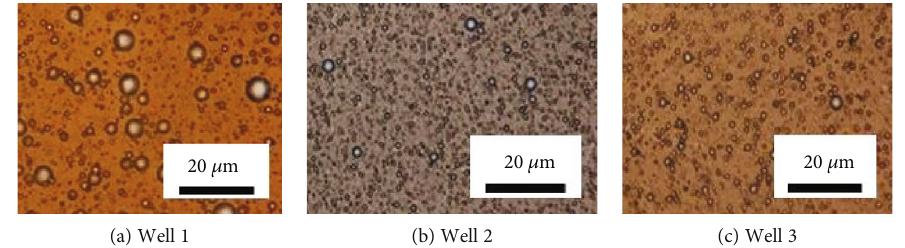
Figure 1: Microscopic images of the produced fl uid of thermal recovery wells.